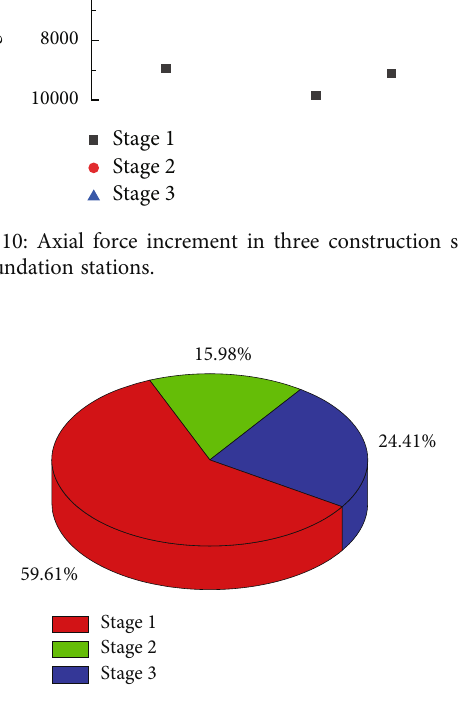
Figure 11: Axial forces increment proportion in di ff erent construction stages of the strip foundation